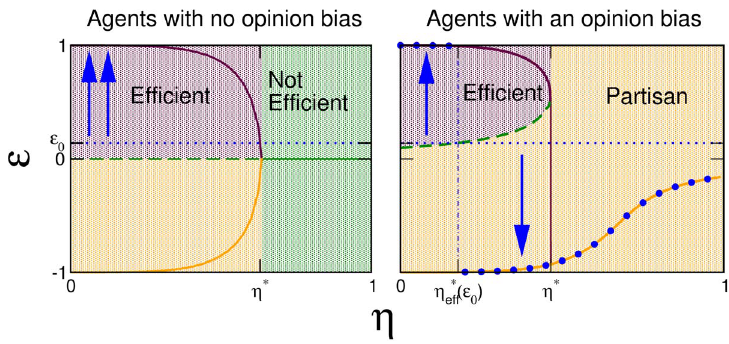
Figure 1. Mean-field solution for a mixed population of agents. For a fixed fraction f of non-naive agents we plot the steady-state efficiency E ss versus the noise amplitude g . We consider two scenarios: (a) agents with no opinion bias and (b) agents with an opinion bias (see text). Continuous lines show stable solutions, and discontinuous lines show unstable solutions. The maroon regions show the set of initial conditions ( g ,0) for which E ss ~ E z w 0 : The orange region covers E ( g ,0) for which E s2 s ~ E { v 0 : The green region covers initial conditions E ( g ,0) for which E ss ~ 0 . In (b), blue dots show E ss ( g ) for the initial condition indicated by the dotted blue line. Blue arrows indicate the steady-state solution that corresponds to the initial condition represented by the blue dotted line.